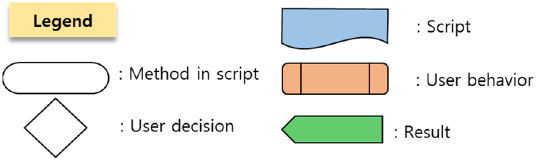
Figure 7. Meaning of Symbols for Algorithm.